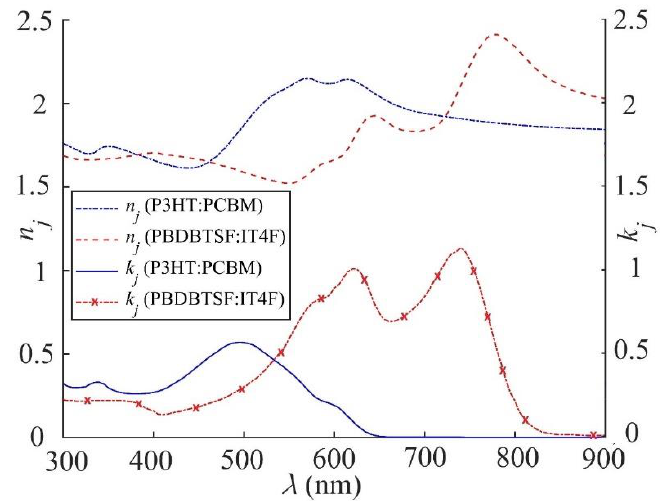
Figure 3. The experimental values of the refractive index ( n j ) and extinction coefficient ( k j ) of the active layer materials P3HT:PCBM [51,55] and PBDBTSF:IT4F [49,52] plotted as a function of the wavelength of the incident light.